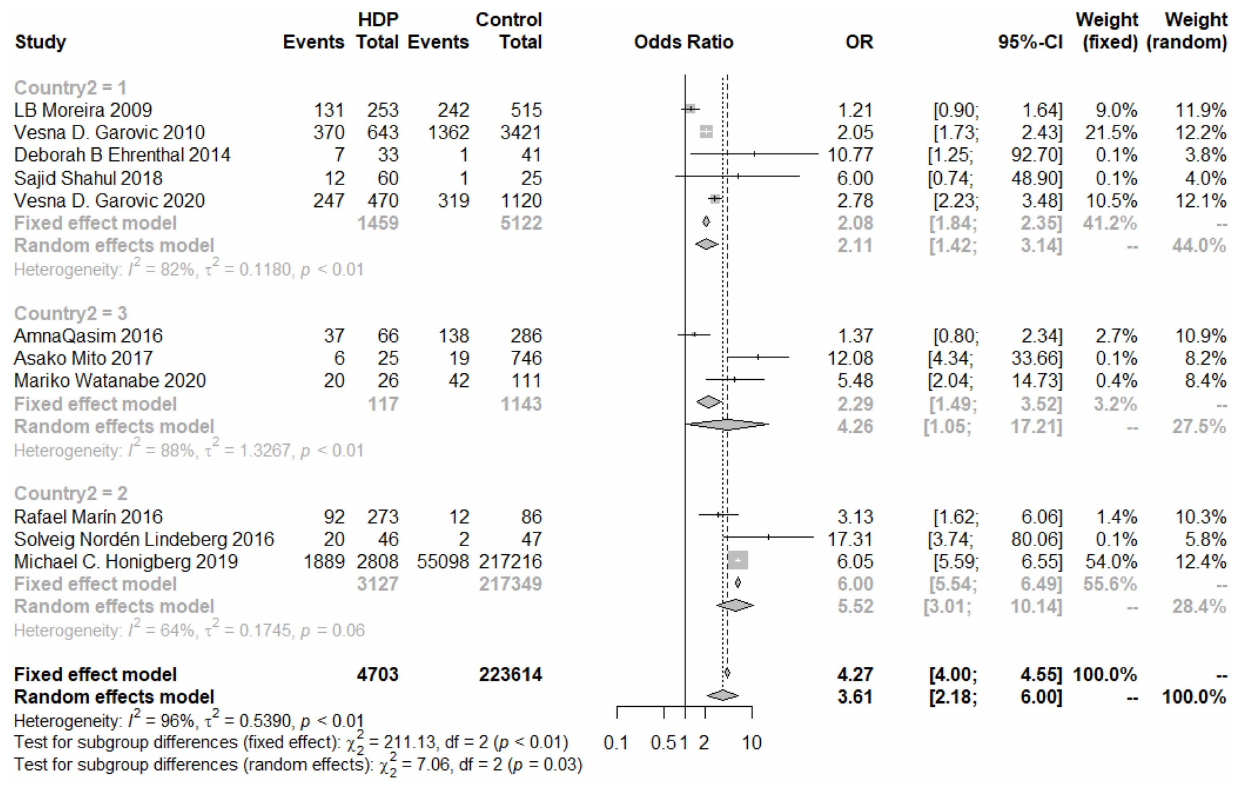
Frontiers in Cardiovascular Medicine |